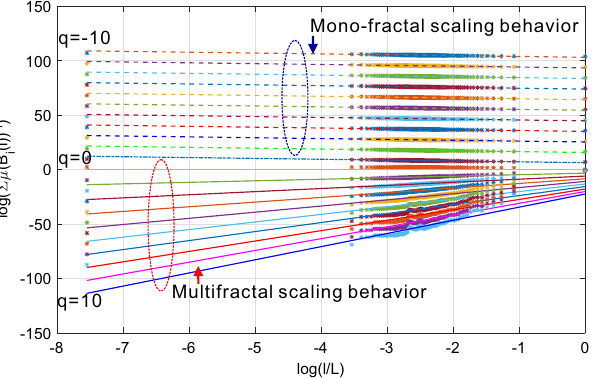
Figure 12. Coexistence of multi-fractal and mono-fractal scaling in the collaboration